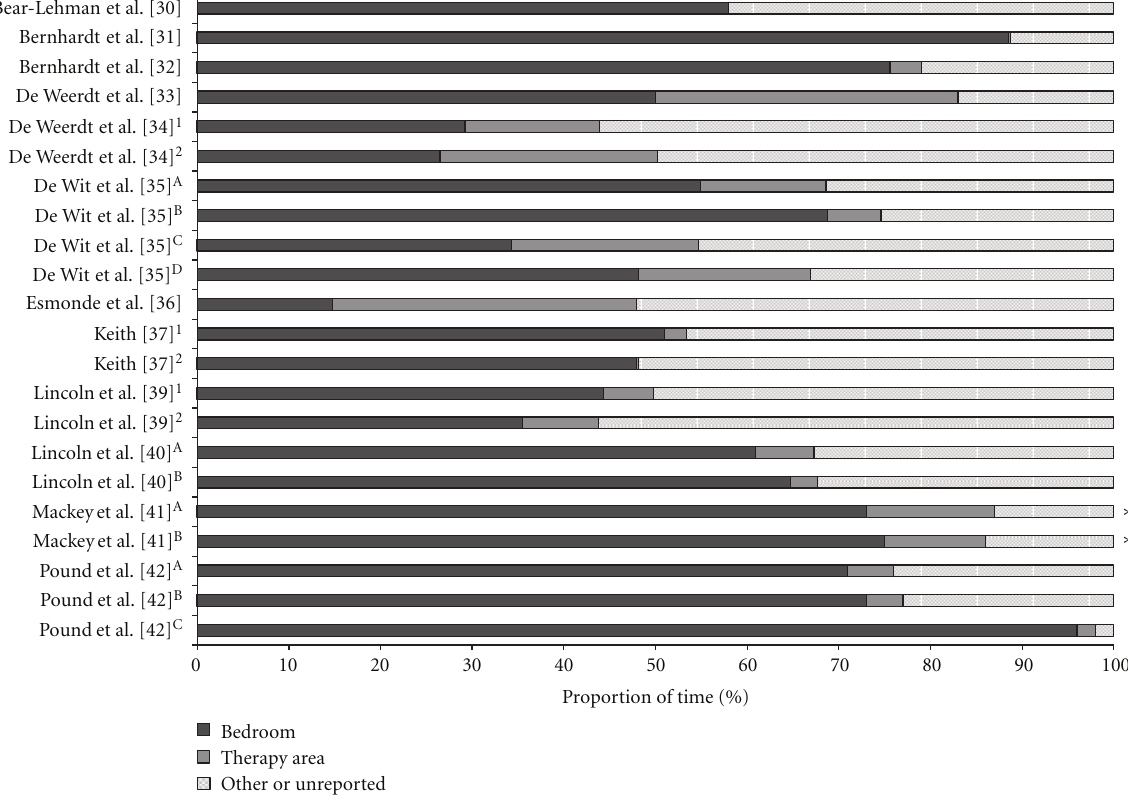
Figure 3: Patient location. 1 and 2 denote di ff erent time periods of observation; A, B, C, and D denote di ff erent hospital locations; ∗ bedside time includes time in lounge and dining